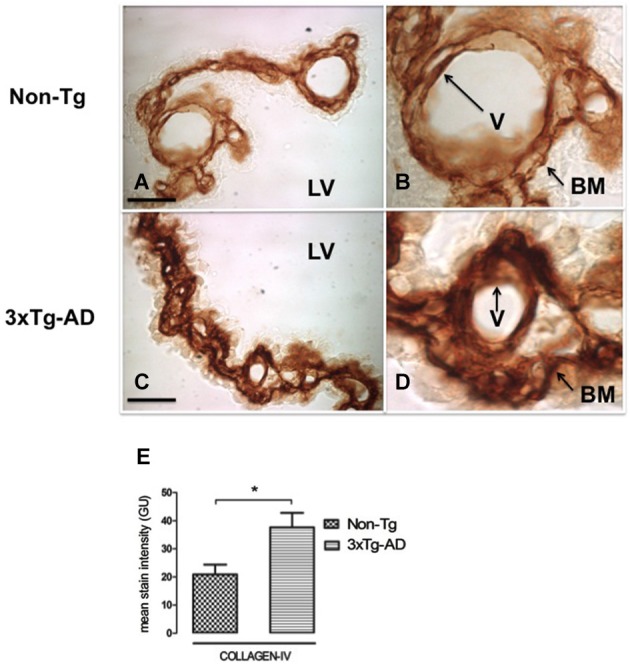
CP immunohistochemistry images from Non-Tg (A,B) and 3xTg-AD mice (C,D) show CP basement membrane and basal membrane of CP vessels (V) immunostained with anti-collagen-IV (arrows). (B,D) are enlarged images of (A,C) respectively. An increased collagen-IV expression in CP of 3xTg-AD (C,D) compared to Non-Tg mice (A,B) is shown. On the left bottom are represented values of stain intensities for collagen-IV (E) as the means ± SEM; LV: lateral ventricle; n = eight animals per group; * p < 0.01 3xTg-AD vs. Non-Tg mice. Scale bars, 60 μm.